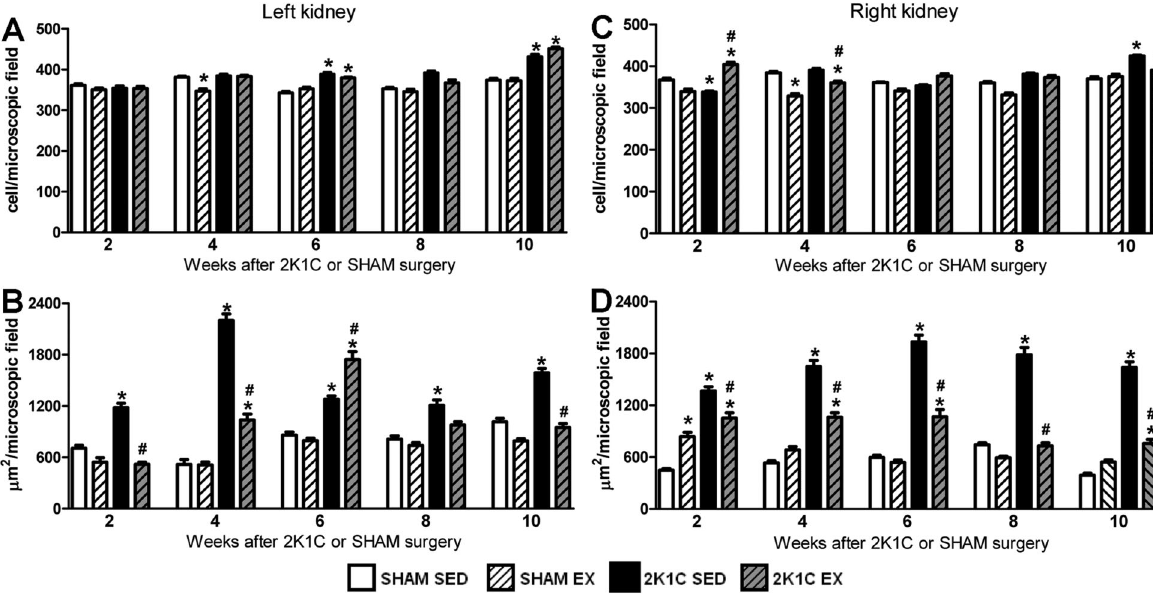
Figure 5. A and C , number of in fl ammatory cells per microscopic fi eld in left (clipped) and right (non-clipped) kidneys, respectively. B and D , collagen deposition ( m m 2 /microscopic fi eld) in left and right kidneys, respectively, of normotensive (SHAM, n=3 – 6) and hypertensive (2K1C, n=3 – 5) rats, either sedentary (SED) or subjected to physical exercise training (Ex), for 2, 4, 6, 8, and 10 weeks of swimming. *P o 0.05 compared to SHAM SED rats. # P o 0.05 compared to 2K1C SED rats (two-way ANOVA followed by Bonferroni